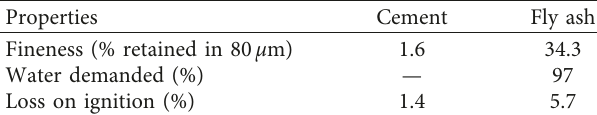
Table 2: Physical composition of cement and fly